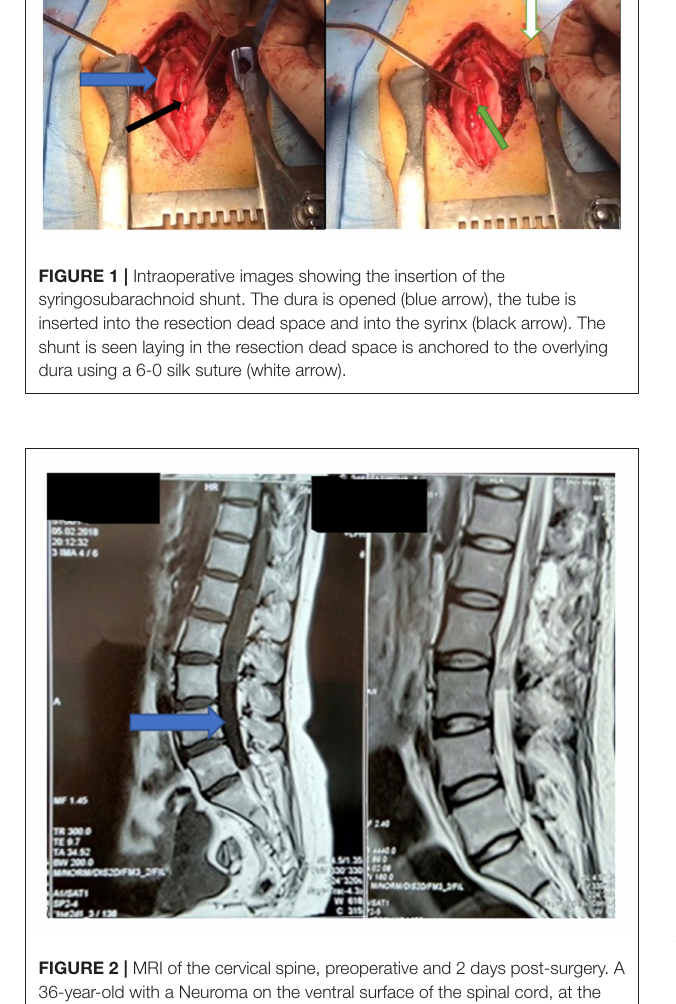
interval (95% CI). The significance level was set at p < 0.05, for all